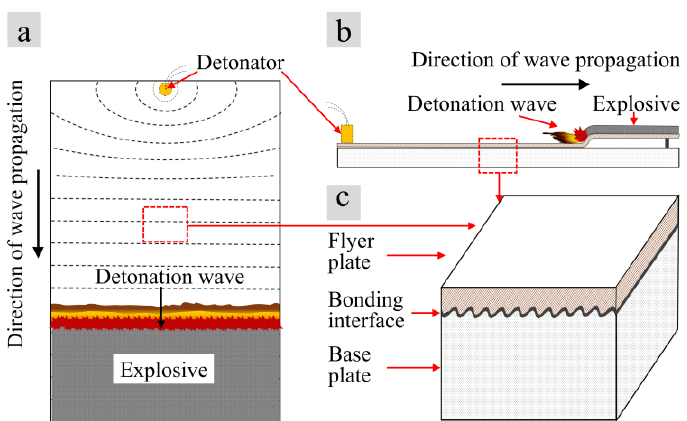
Figure 1. Schematic of explosive welding process and the typical bonding interfacial morphology: ( a ) top view of explosion welding; ( b ) side view of explosive welding; and ( c ) typical bonding interface.